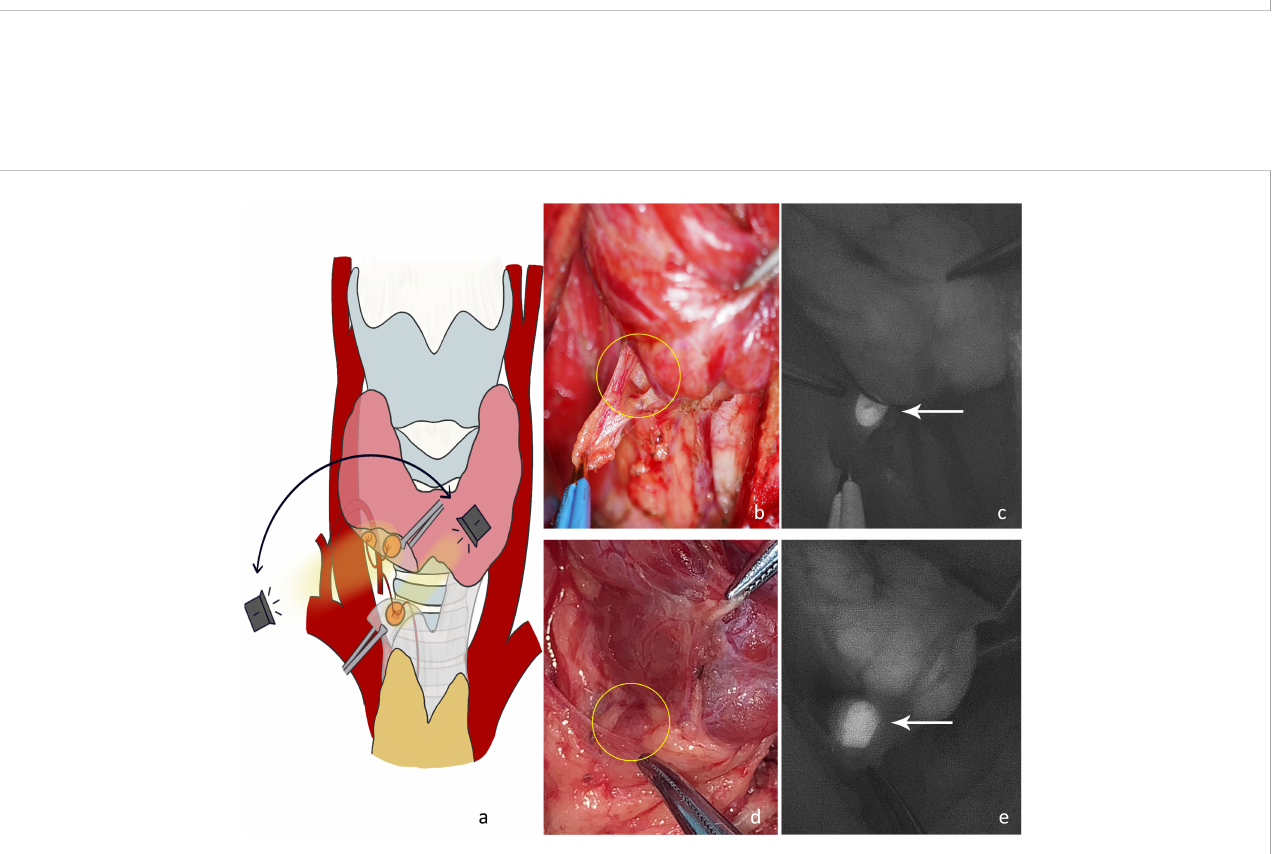
FIGURE 3 (A) The dorsal side of the thyroid gland and thyrothymic ligament were detected to locate the right inferior parathyroid gland. (B) Type C3 gland on the dorsal side of the thyrothymic ligament under normal white light (yellow circle). (C) The NIRAF shows a type C3 gland (white arrow). (D) Intrathymic type C5 gland with high position under normal white light (yellow circle). (E) The NIRAF shows a type C5 gland (white